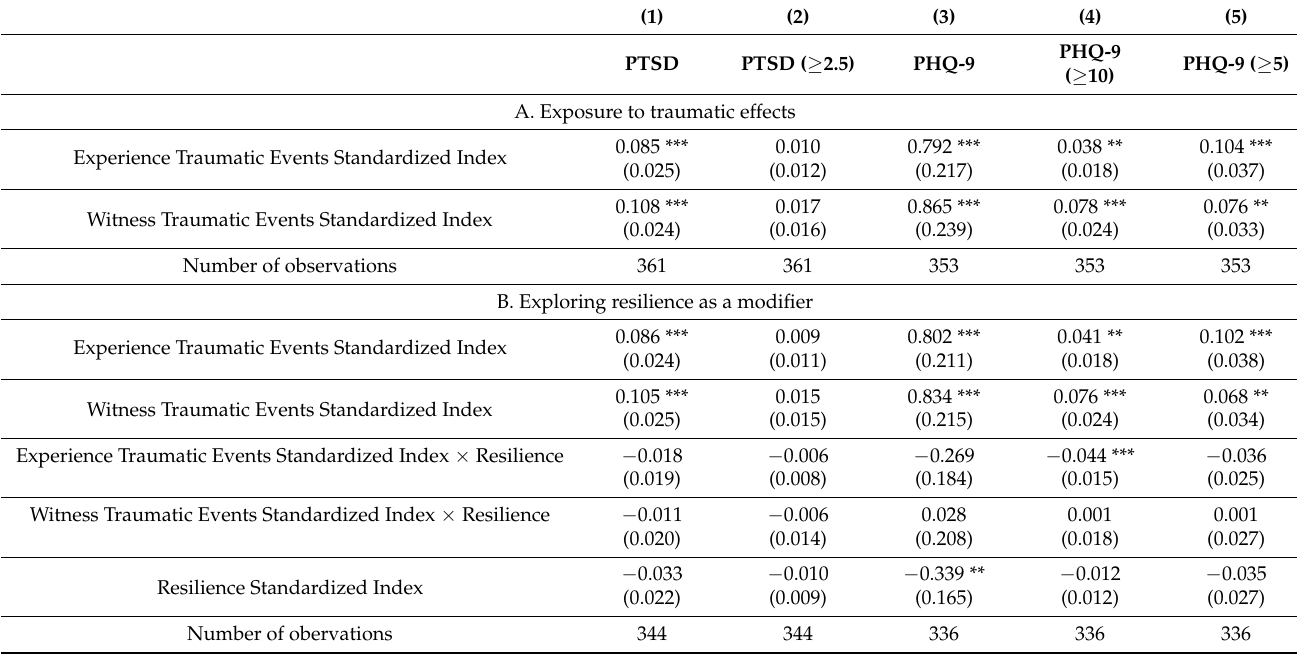
Table 2. Relationship between cumulative exposure to trauma and adolescent mental health among Rohingya